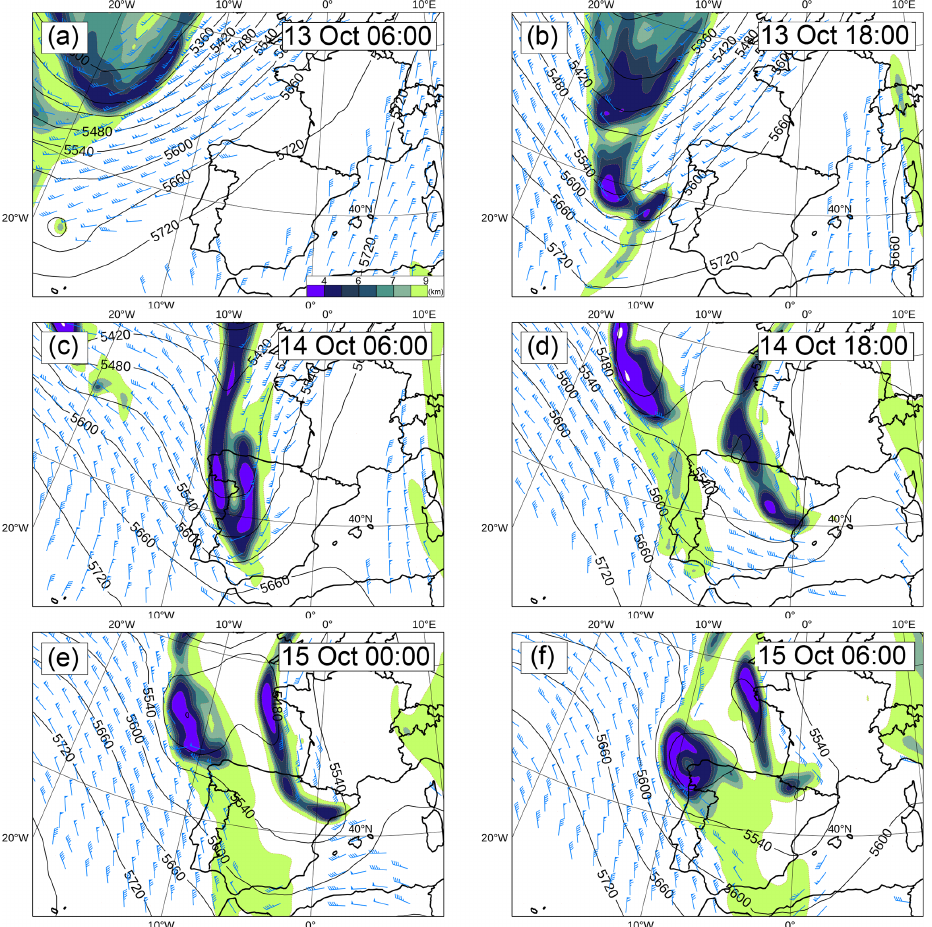
Figure 2. Same as Fig. 1 but for geopotential height at 500hPa (solid lines, gpm), geopotential height (coloured areas, gpkm), and horizontal winds (barbs, ms − 1 ) along the 2PVU